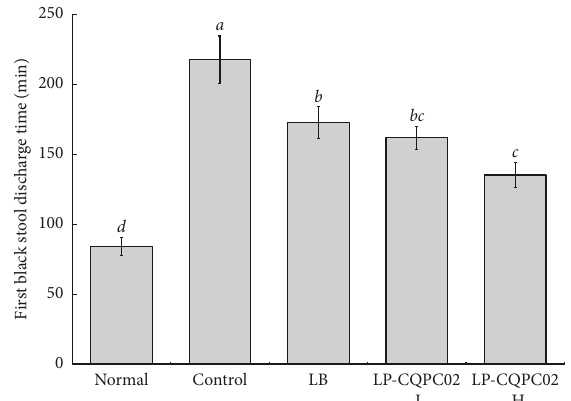
Figure 2: First black stool discharge time of the mice. The values presented are the mean ± standard deviation. a–d The mean values with different letters in the same bars are significantly different ( p < 0.05) according to Duncan’s multiple-range test; there was no significant difference in the same letter representation between the two bars ( p > 0.05), but there was significant difference in the different letter representation ( p < 0.05). LB: Lactobacillus del- brueckii subsp. bulgaricus (1.0 × 10 9 CFU/kg b.w. gavage); LP- CQPC02-L : Lactobacillus plantarum CQPC02 (1.0 × 10 8 CFU/kg b.w. gavage); and LP-CQPC02-H: Lactobacillus plantarum CQPC02 (1.0 × 10 9 CFU/kg b.w.